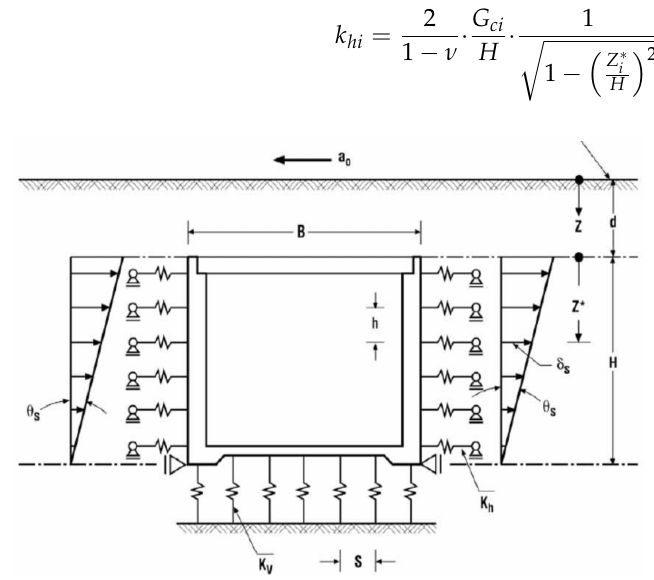
Figure 3. Horizontal spring model for underground structures.